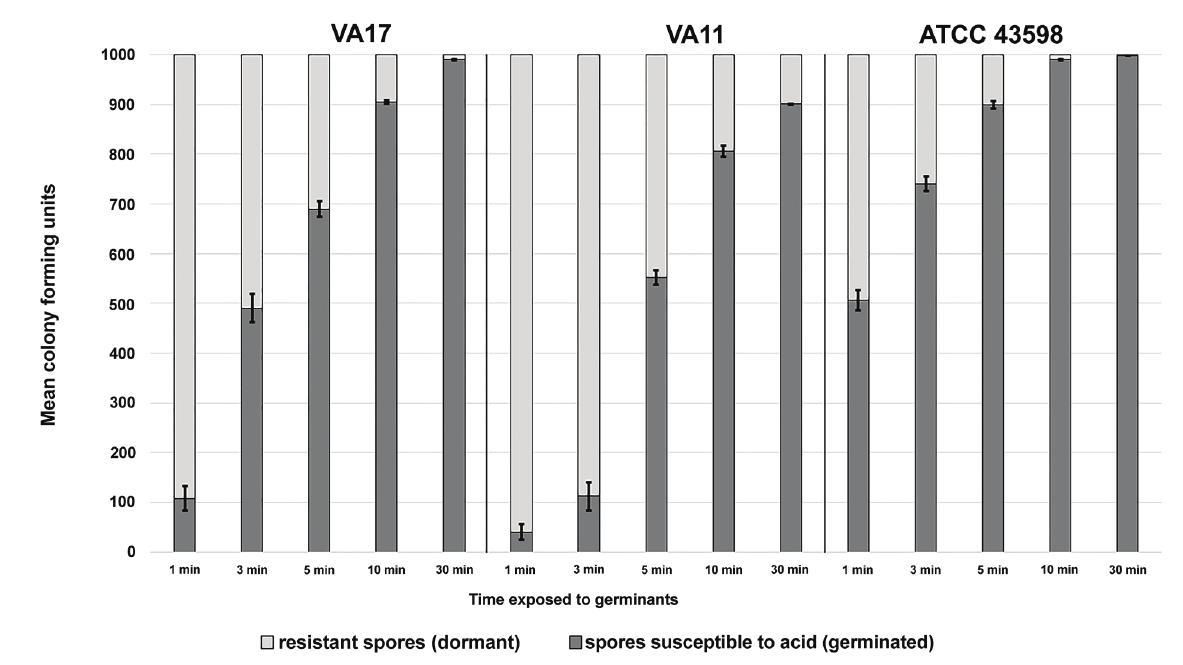
Figure 6. Germinated spores are susceptible to killing by pH 1.5 hydrochloric acid. One thousand colony forming units (CFU) of C. difficile VA17, VA11, and ATCC 43598 spores were exposed to 1 mL of germinants in a test tube for 1, 3, 5, 10, or 30 minutes under ambient conditions (22˚C, aerobic). At the appropriate time point, spores were washed 3 times to remove germinants and then resuspended in 1 mL of pH 1.5 hydrochloric acid for 10 minutes. Spore suspensions were neutralized with phosphate-buffered saline and washed to remove hydrochloric acid. Contents were spread on a plate to enumerate the recovery of viable spores. The means of data from triplicate experiments are presented. Error bars indicate standard